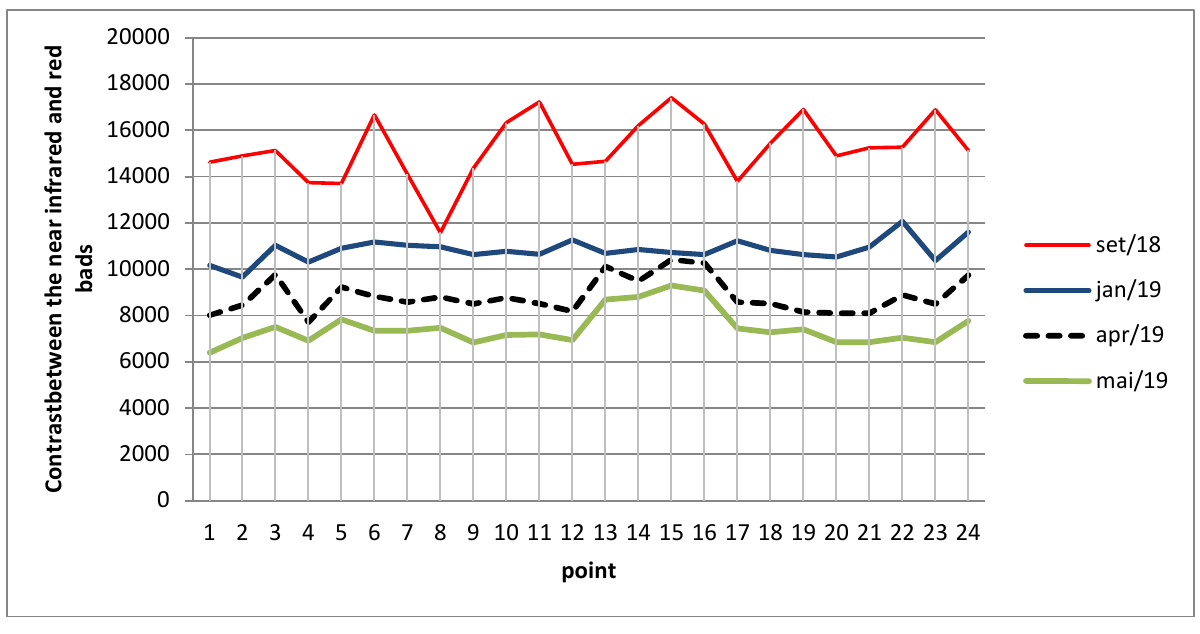
Figure 5– Contrast between the near infrared and Red bands along the Córrego do Feijão